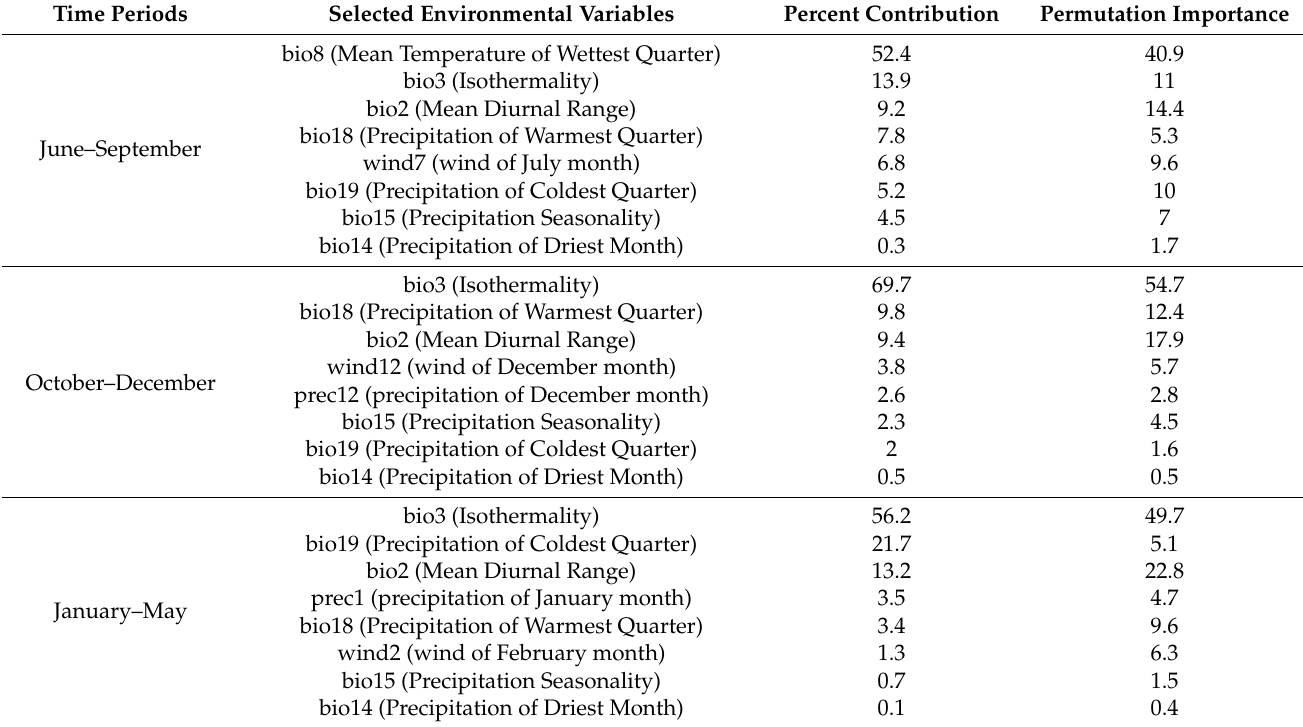
Table 4. Percent contribution and permutation importance of the environmental variables in terms of India’s suitability. Time Periods